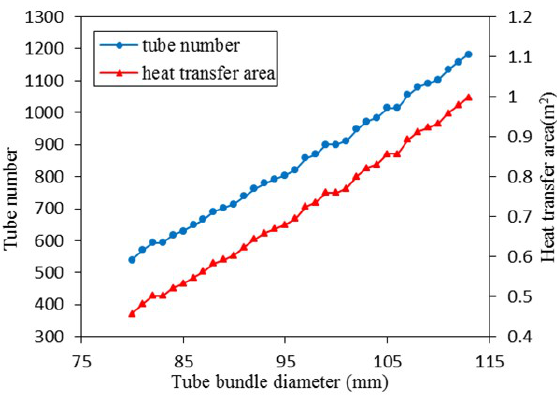
Figure 7. Tube number and heat transfer area separately versus tube bundle diameter.